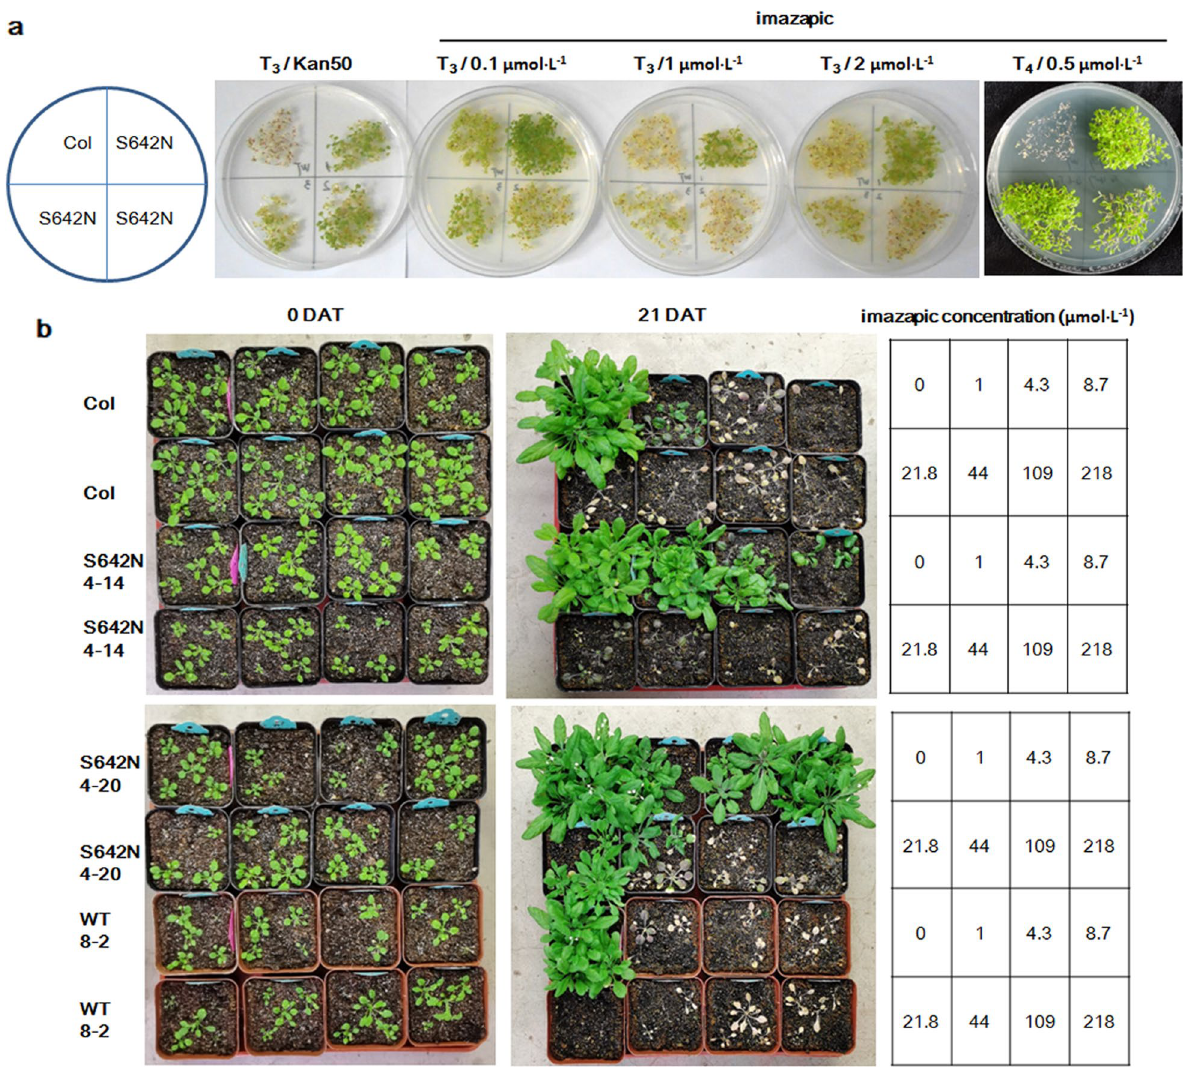
Fig. 5 Overexpression of mutant Gh_D10G1253 conferred herbicide tolerance in Arabidopsis . a At 21 DAT, transgenic Arabidopsis S642N (T 3 and T 4 generations) cultured on 1/2 MS supplemented with different concentrations of imazapic. Transgenic lines of the T 3 generation and the wild-type Columbia (Col) were sown on 1/2 MS supplemented with 50 mg L − 1 kanamycin to confirm the transgenics. b At 21 DAT, transgenic Arabidopsis · S642N